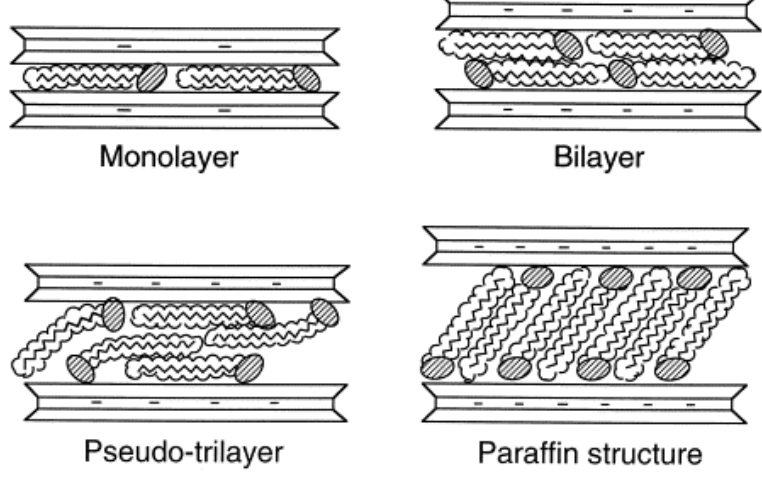
Figure 2. Possible orientations of the alkyl ammonium chains in the interlayers of aluminosilicates as deduced from the X-ray diffraction studies. Reproduced from reference [40] with permission from